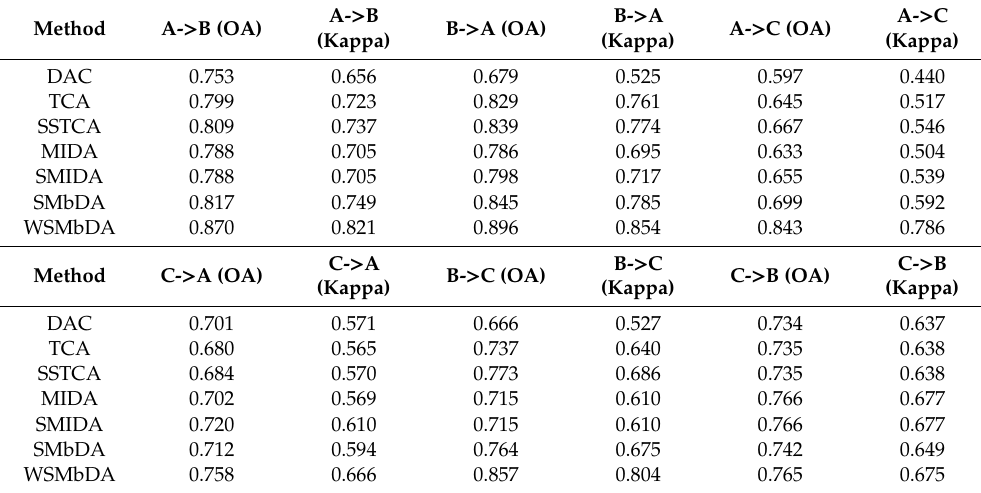
Table 1. Precision evaluation results in